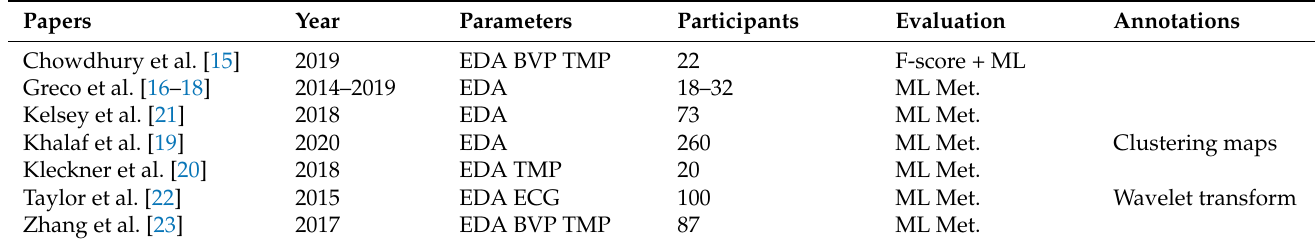
Table 4. Physiological Signals Used for Arousal Detection.